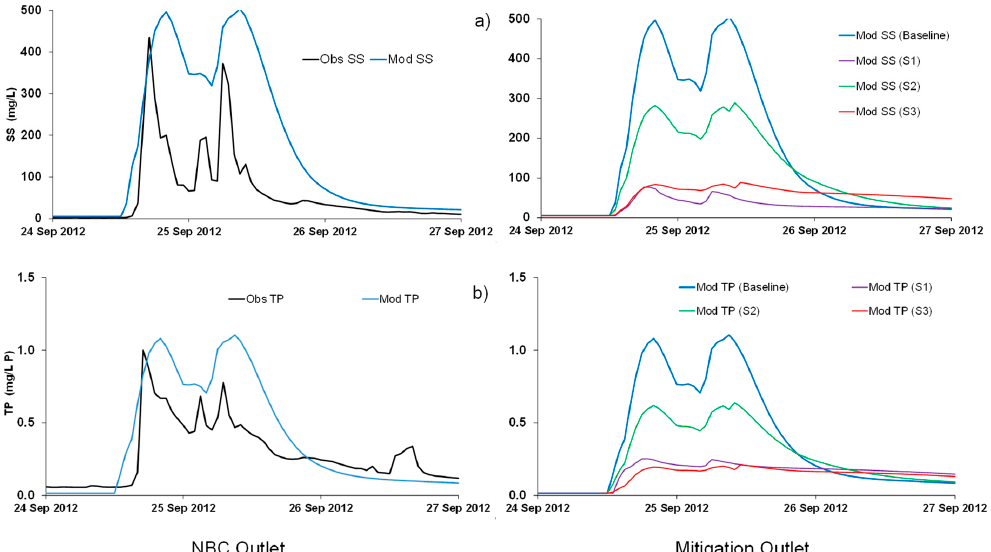
Figure 7. ( a ) LH pane shows the modelled (“Mod”) and observed (“Obs”) SS concentrations at the NBC outlet. RH pane shows the SS concentrations at the mitigated sub-catchment outlet (Scenarios 1–3 shown by colored lines, with baseline in blue). ( b ) LH pane shows modelled (black) and observed (blue) TP outlet (Scenarios 1–3 shown by colored lines, with baseline in blue). Only Event 3 is